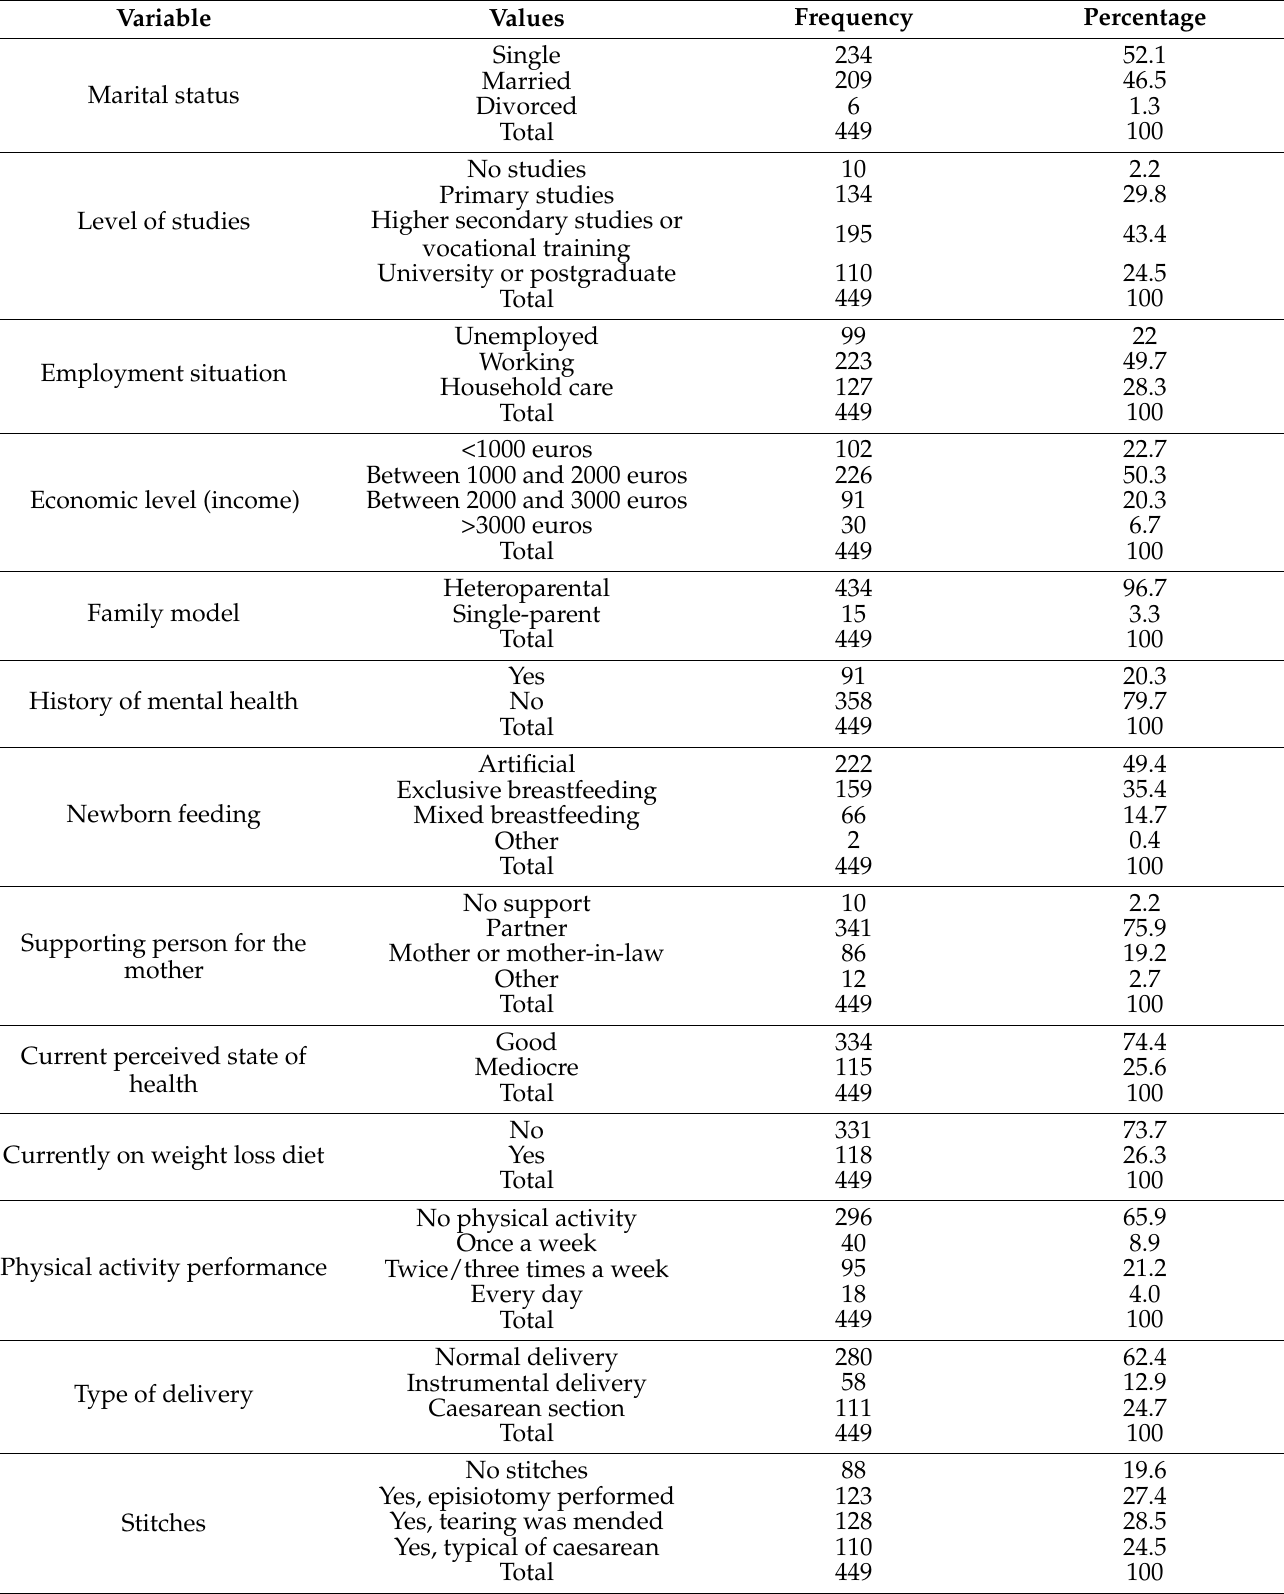
Table 2. Descriptive analysis of qualitative